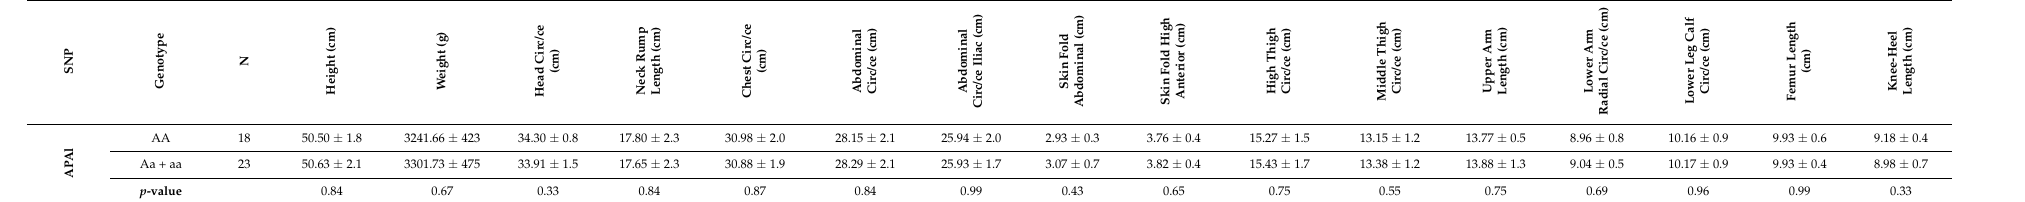
Table 4. Birth neonatal anthropometry (neonatal vitamin D status at birth >25 nmol/L) according to neonatal VDR